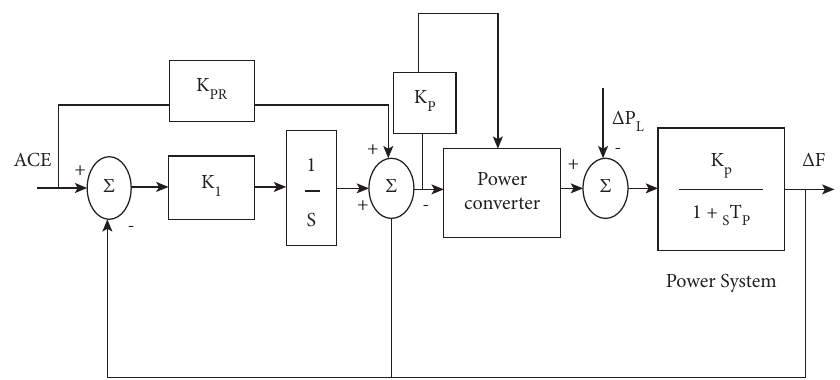
Figure 3: Configuration of the PDFF control